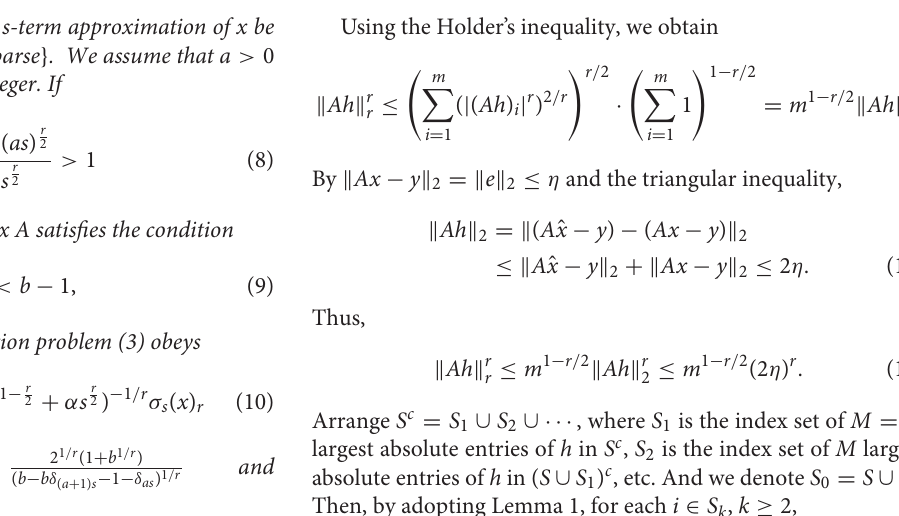
ℓ 1 norms with different α and r . The first row corresponds to the cases that r − 0.1,0.4,0.7 with fixed α = =